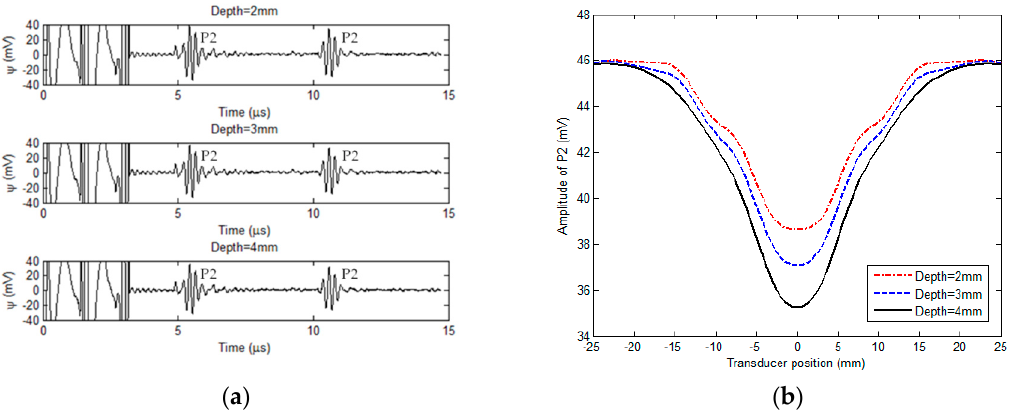
Figure 12. Experimental results with the bobbin coil for signal acquisition: ( a ) Acquired signals vs. corrosion depths; and ( b ) scanning curves for corrosion in different depths.